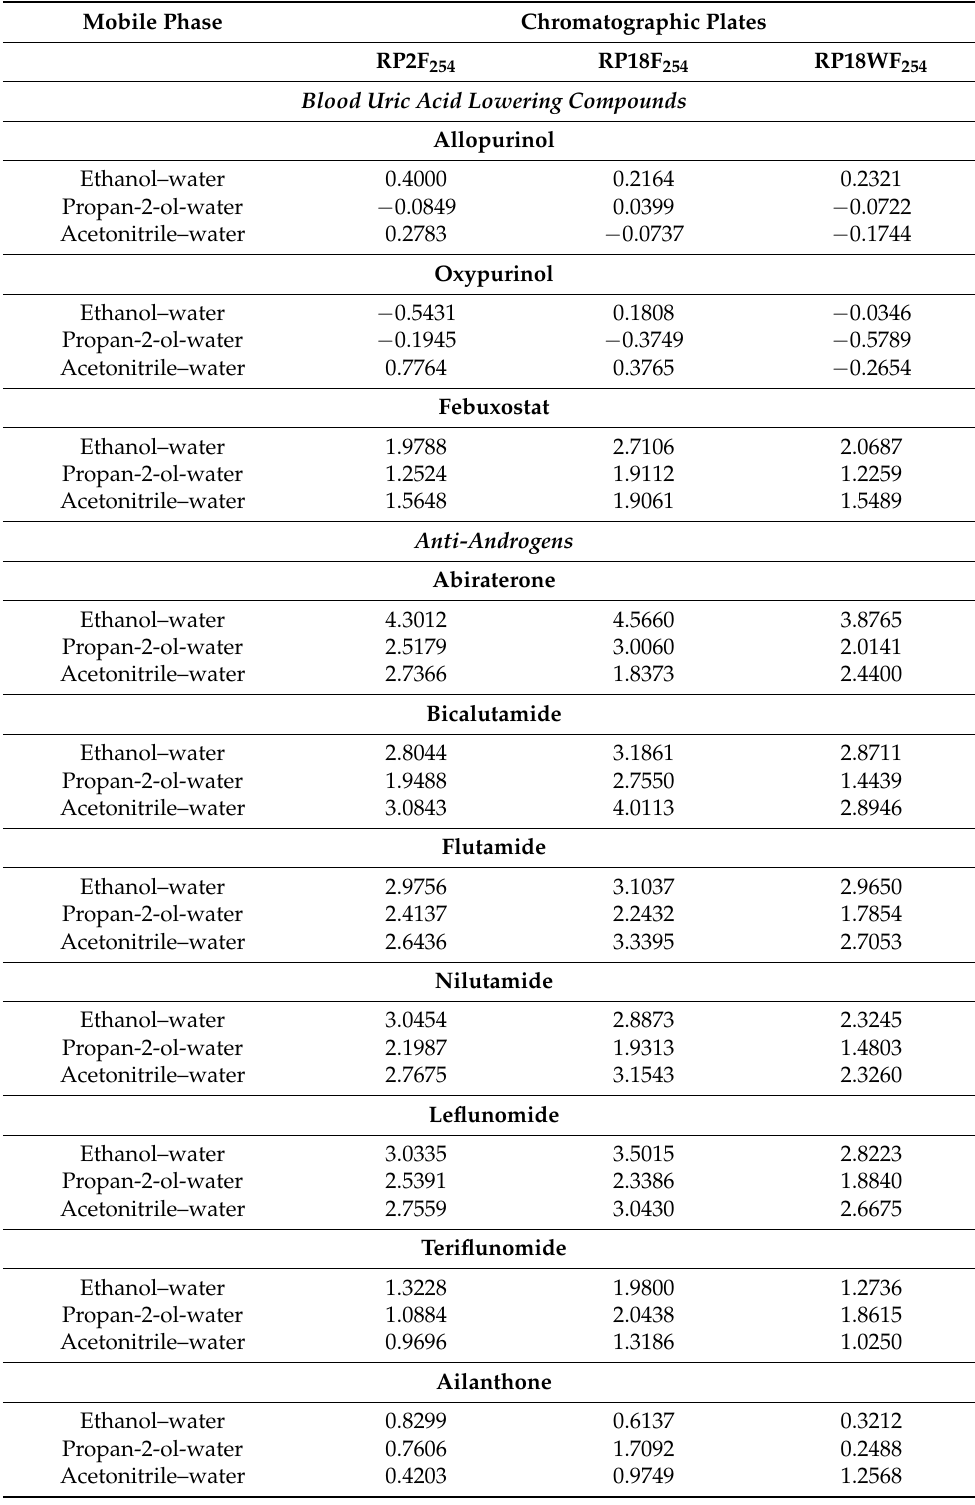
Table 3. Comparison of R MW values of studied compounds obtained with the use of different stationary phases in the RP-TLC/RP-HPTLC